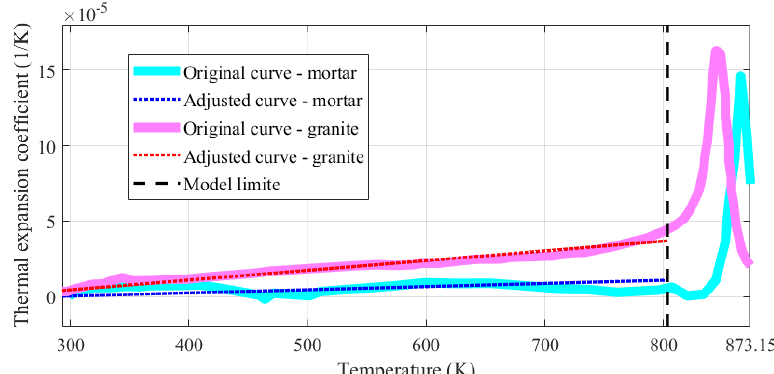
Figure 7. Experimental and simplified relations between thermal expansion coefficient and